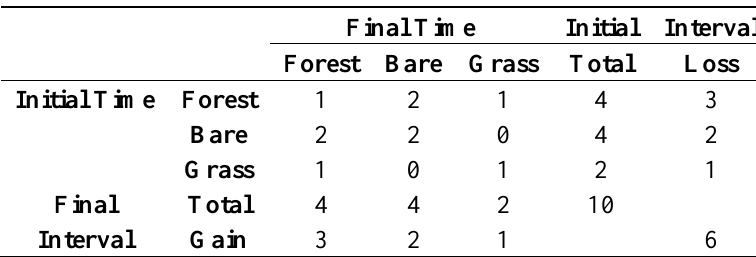
Table 4. Matrix that shows uniform transition intensities to Forest and from Forest for active Forest.